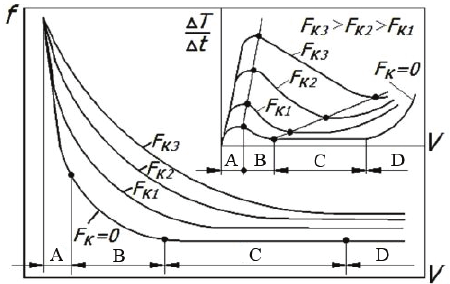
Figure 10. Borders of friction regimes depending on relative area of microgrooves F к and slip velocity V